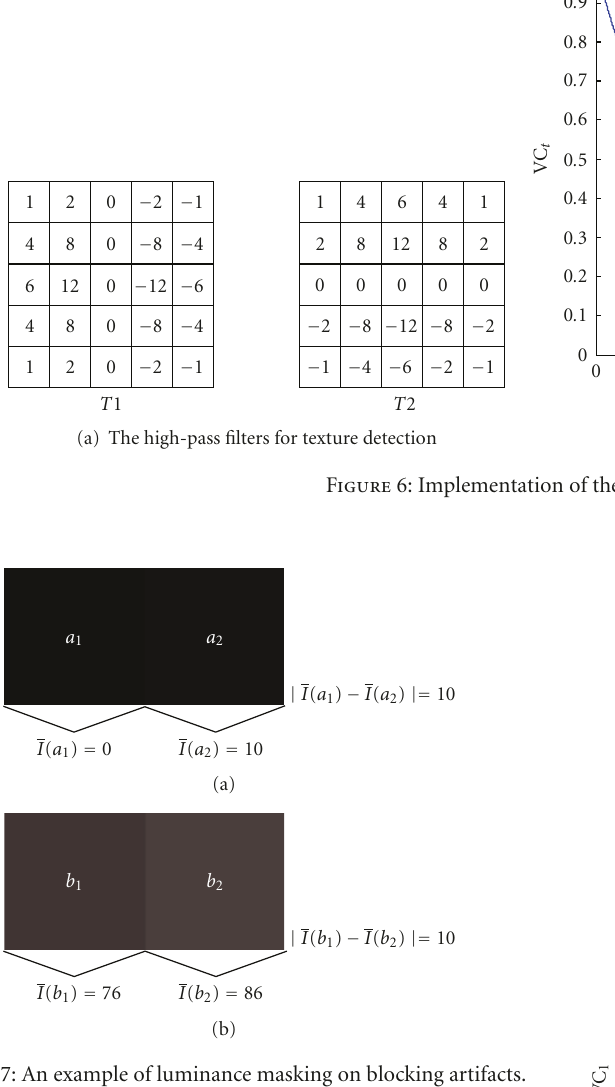
Figure 7: An example of luminance masking on blocking artifacts.